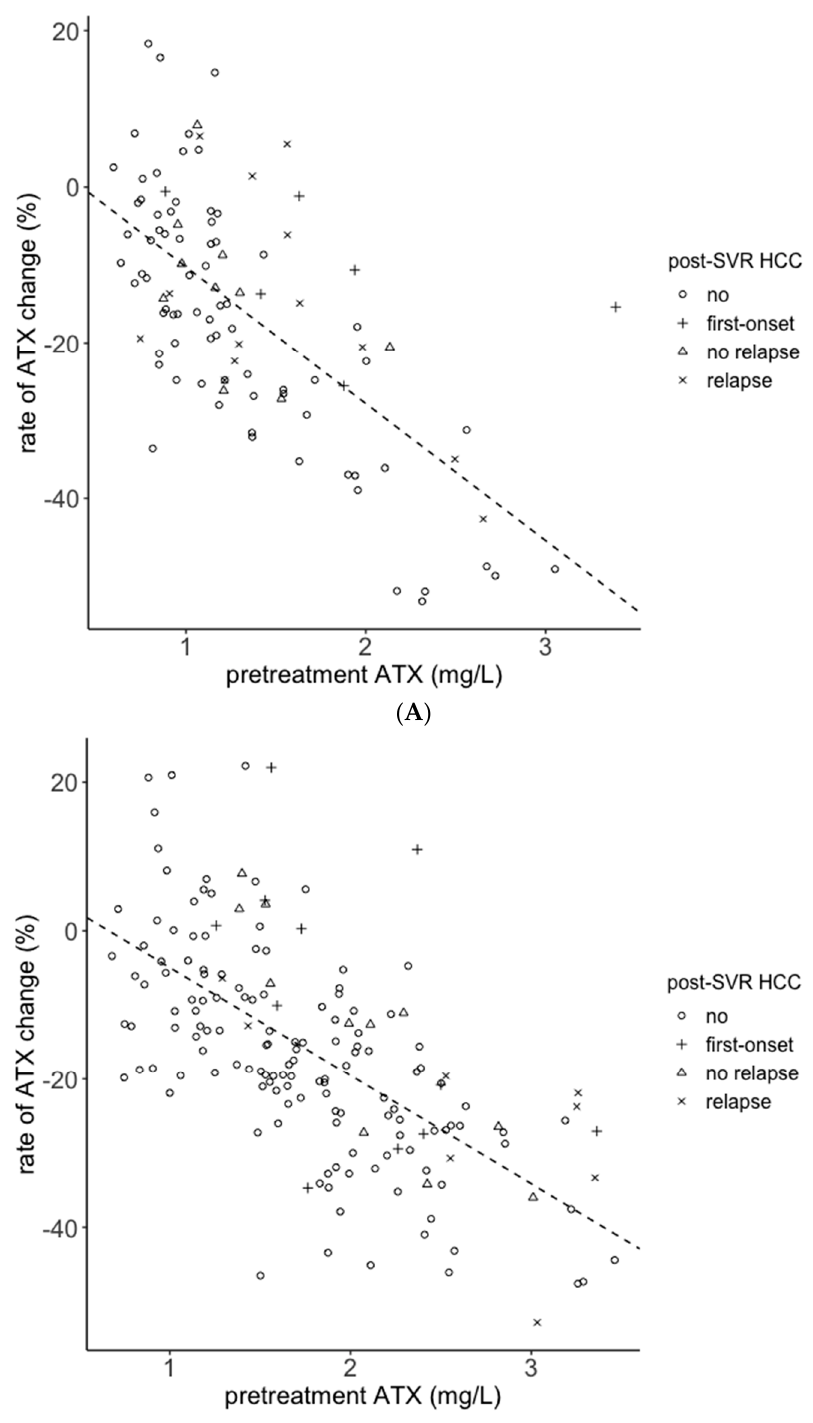
Figure 6. Association between pretreatment ATX levels and the rate of ATX change. Data from Cohort B were used for the analysis. Data from male patients ( A ) and female patients ( B ) are shown. Dotted lines represent the regression lines. no: the patients with no HCC history and no carcinogenesis; first-onset: the patients with no HCC history and post-SVR HCC development; no relapse: the patients with HCC history and no carcinogenesis; relapse: the patients with HCC history and post-SVR HCC development. ATX: autotaxin; SVR: sustained viral response; HCC: hepatocellular carcinoma.